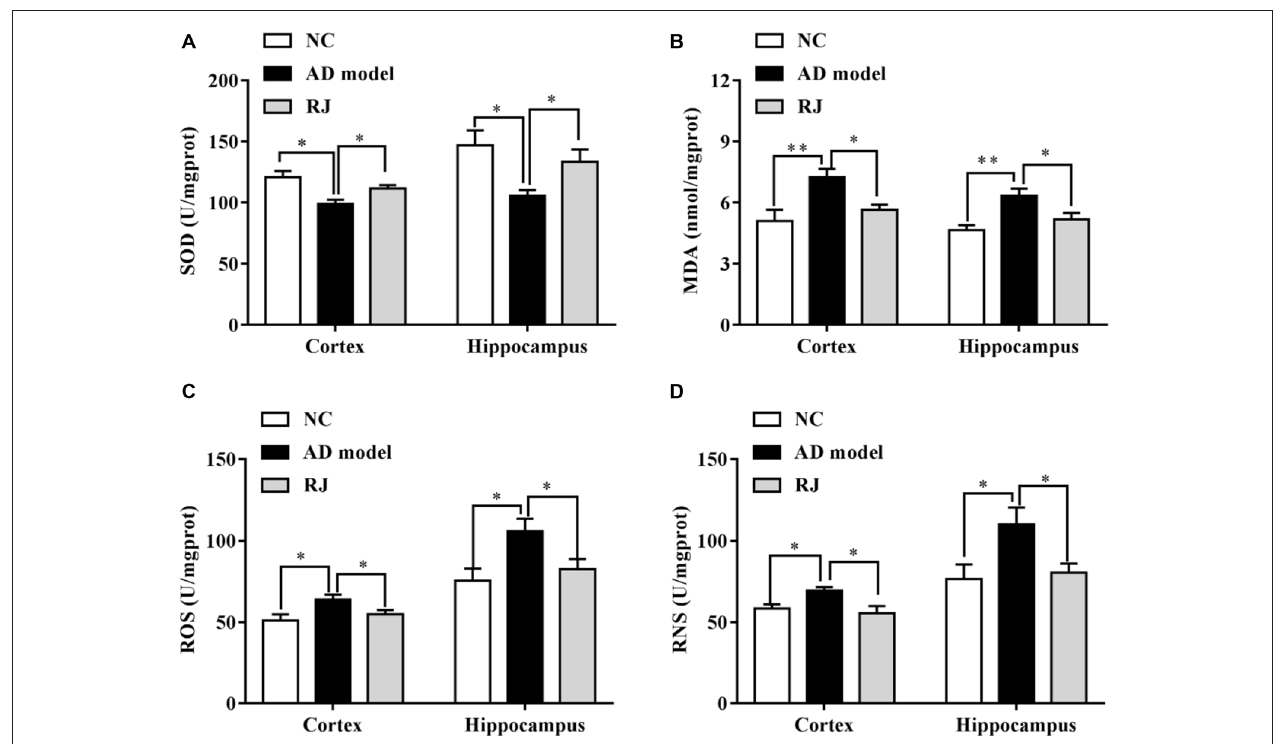
FIGURE 6 | RJ enhanced the anti-oxidative capacities in the brain of AD rabbits. (A) Changes of superoxide dismutase (SOD) activities in the cortex and the hippocampus of the three groups, n = 8 rabbits per group. (B) Changes of malonaldehyde (MDA) contents in the cortex and the hippocampus of the three groups, n = 8 rabbits per group. (C) Changes of reactive oxygen species (ROS) levels in the cortex and the hippocampus of the three groups, n = 6 rabbits per group. (D) Changes of reactive nitrogen species (RNS) levels in the cortex and the hippocampus of the three groups, n = 6 rabbits per group. Data are presented as mean ± SEM. ANOVA with post hoc Tukey’s test was used (A–D) . ∗ P < 0.05, ∗∗ P < 0.01 vs. the AD